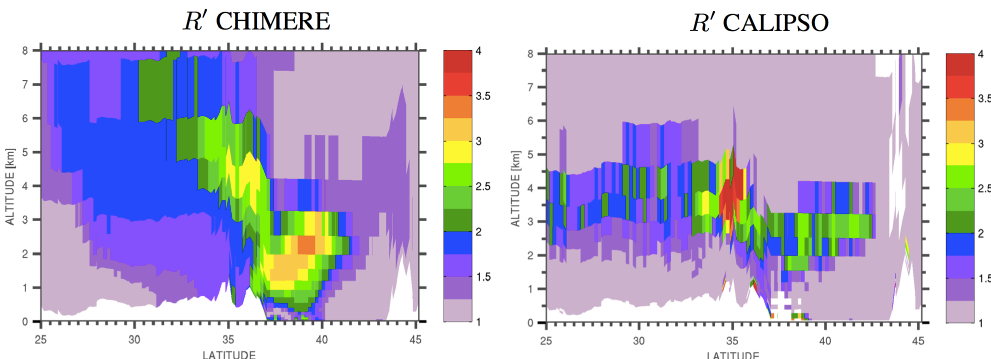
Fig. 14. Attenuated Scattering Ratio by CHIMERE (left) and CALIOP (right) for the nighttime portion of the orbit of the 9 July 2007. The initial profiles corresponding to cloud contaminated data are filtered out. The cloud-free data are averaged into the model’s horizontal and vertical resolutions for comparison to the simulated R 0 ( z ) profiles.